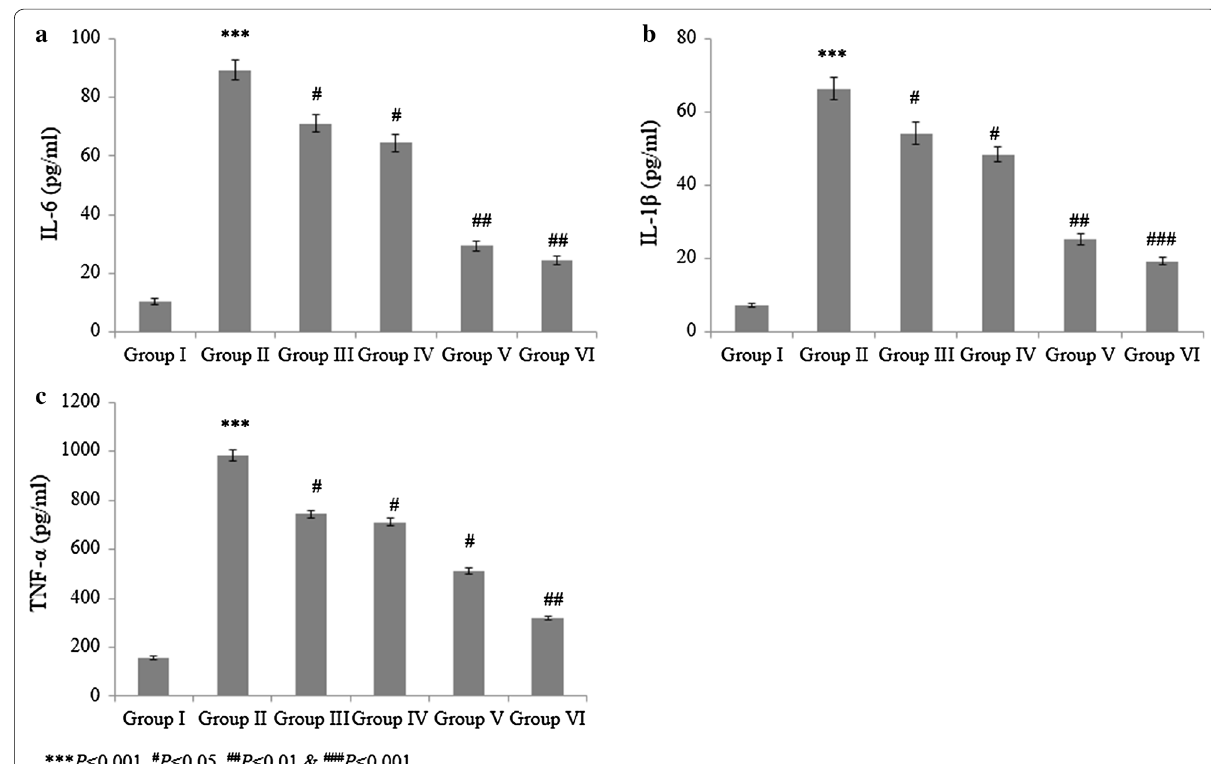
Fig. 5 Effects of erythropoietin and sesame oil on levels of the inflammatory markers a IL-6, b IL-1β and c TNF-α in rat with ischemic kidney injury